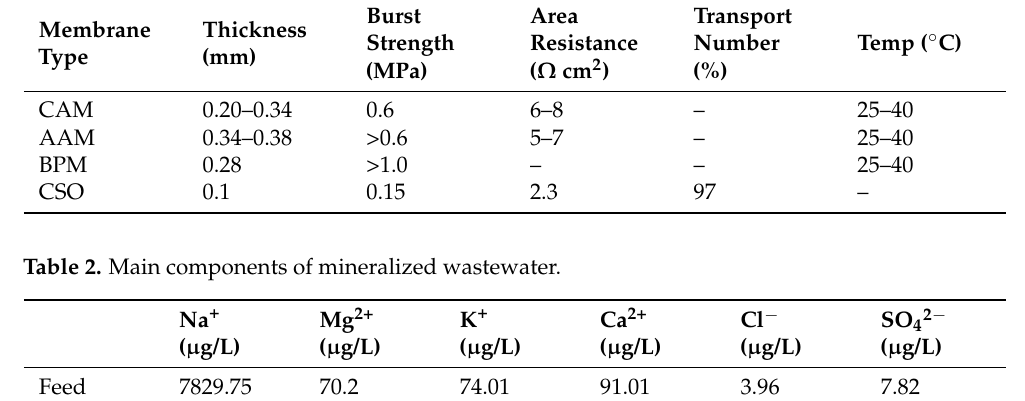
Table 1. Main properties of the membranes.